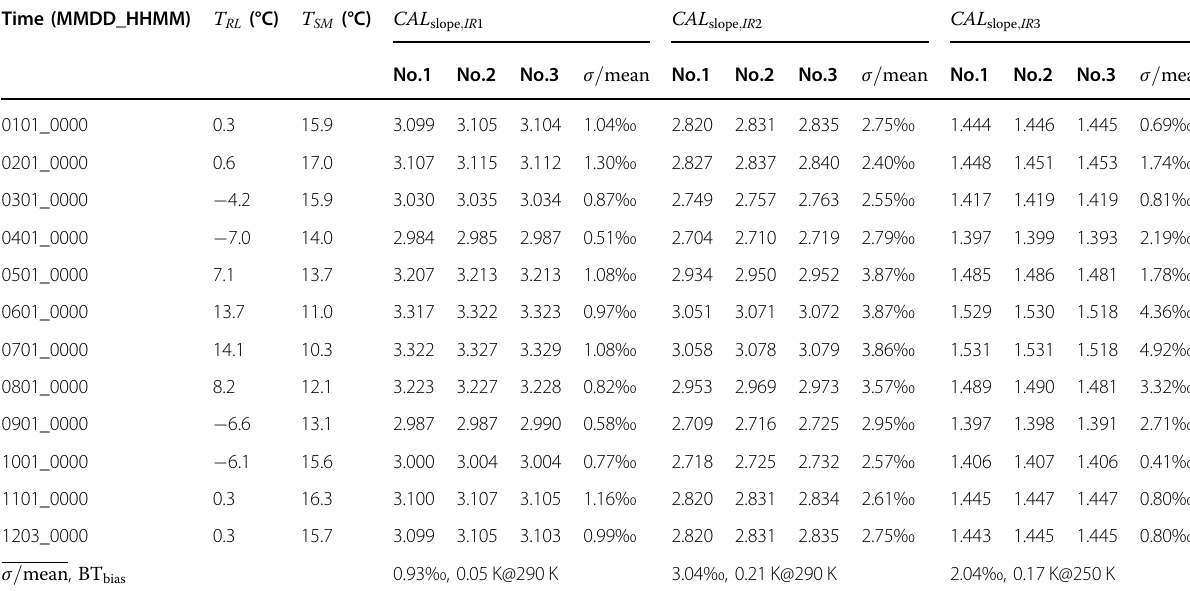
Table 2 Comparison of calibration slopes for IR1 – IR3 bands from different SIRC coef fi cients of FY-2F satellite with some typical cases in